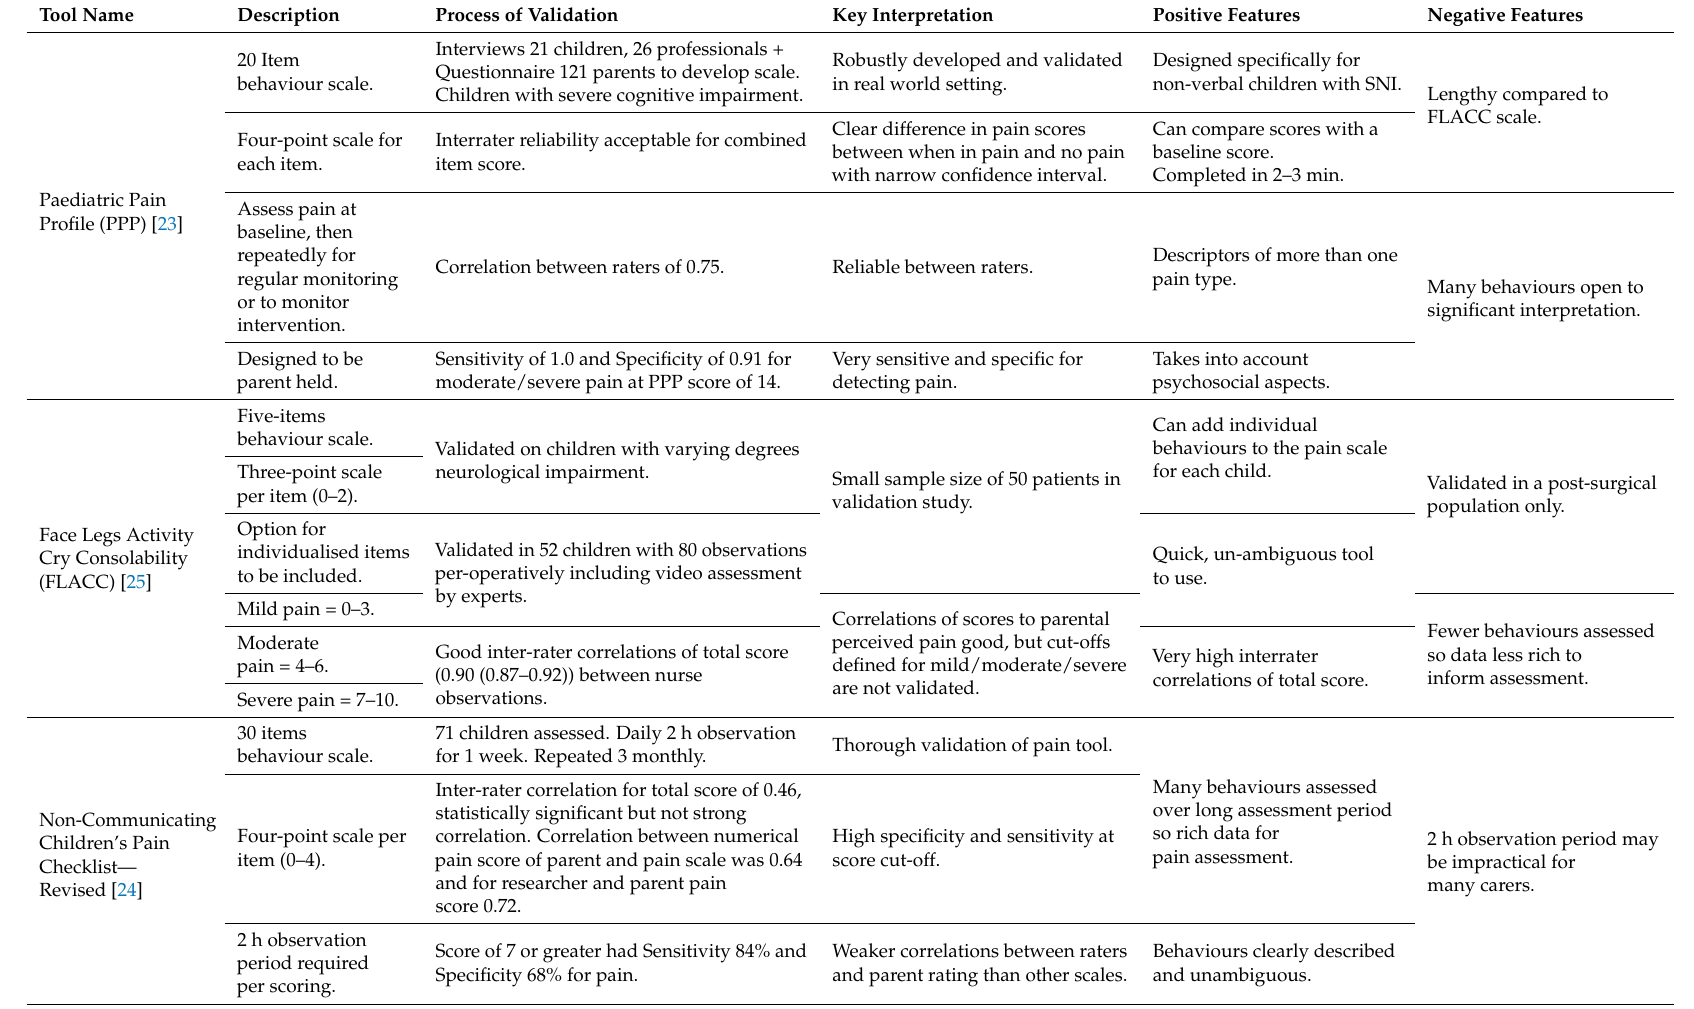
Table 4. Pain assessment tools in children with severe neurological impairment